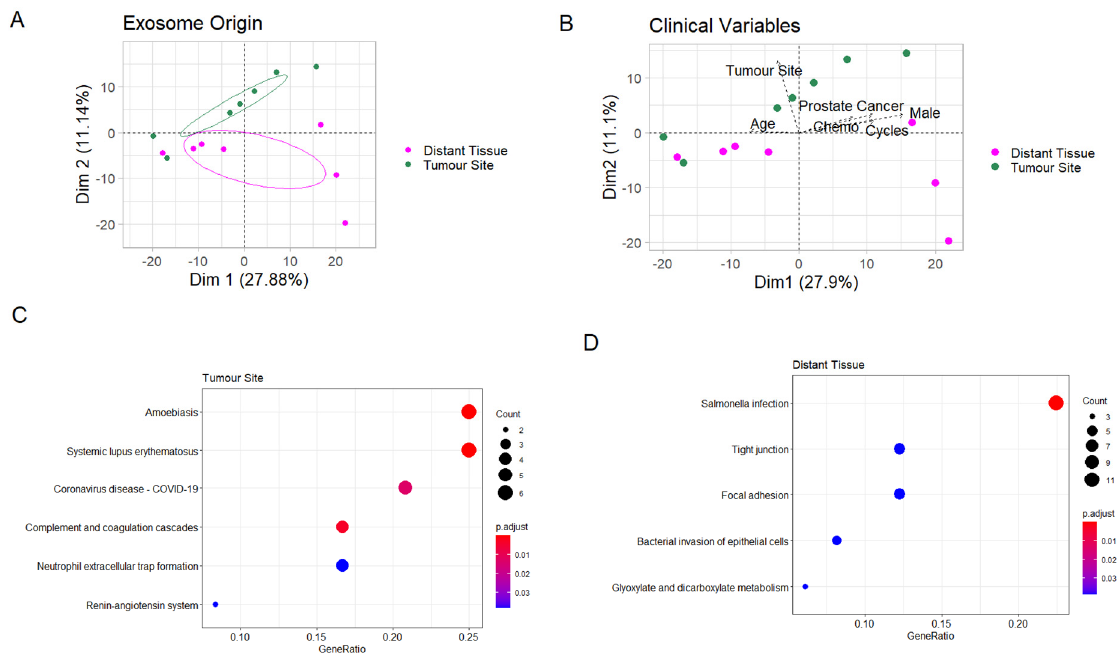
Figure 3. Comparison of exosomes from the tumour site and distant tissue. ( A ) Principal component analysis (PCA). Ellipses represent 95% confidence intervals. ( B ) PCA biplot. The arrows represent clinical parameters, their direction shows how they correlate with the two PCA axes, and their length increases with the correlation value. ( C , D ) Enrichment plots showing enriched pathways among proteins significantly higher at the tumour site and in distant tissue, respectively.